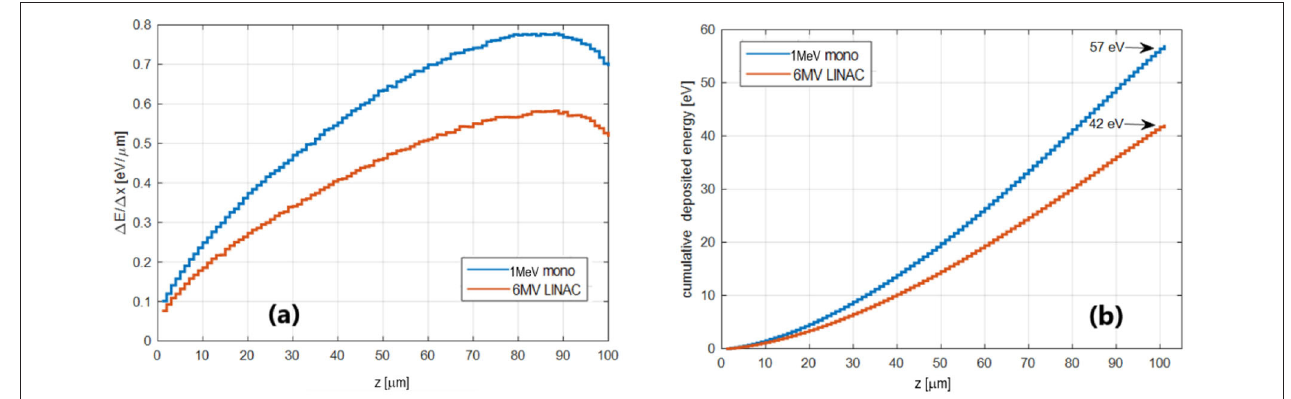
FIGURE 5 | (a) Average energy deposited per photon in 1 µ m slices along z . (b) Cumulative deposited energy per photon as a function of the traversed thickness. In each subfigure, the two curves refer to a monoenergetic 1 MeV beam and to a 6MV LINAC beam.